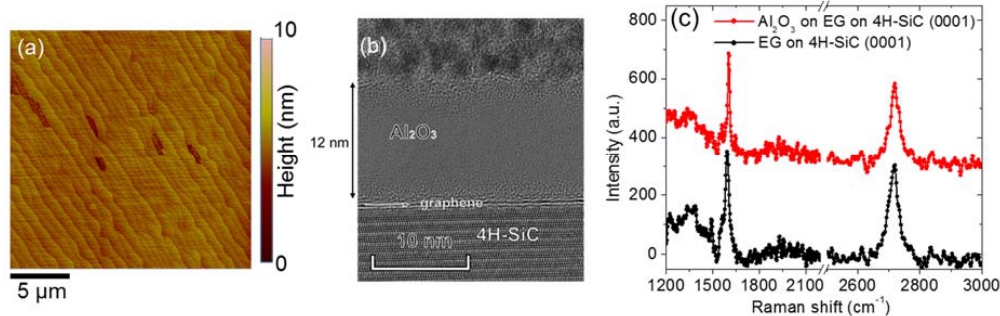
Figure 5. ( a ) AFM morphology (20 µ m × 20 µ m scan area) of Al 2 O 3 directly grown on 1 L EG on SiC Figure 5 ( a ). AFM morphology (20  m × 20  m scan area) of Al 2 O 3 directly grown on 1 L EG on SiC by 190 water / TMA ALD cycles. ( b ) Cross-sectional TEM image of the Al 2 O 3 layer. ( c ) Representative by 190 water/TMA ALD cycles . ( b ) Cross ‐ sectional TEM image of the Al 2 O 3 layer. ( c ) Representative Raman spectra of virgin EG and after the Al 2 O 3 deposition. Images adapted with permission from Ref. [21], copyright Wiley